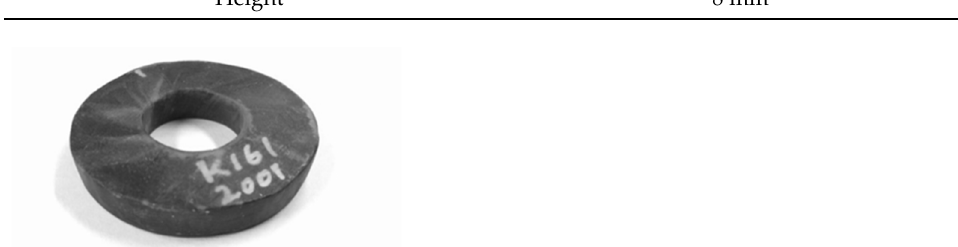
Figure 3. Photograph of HTS.